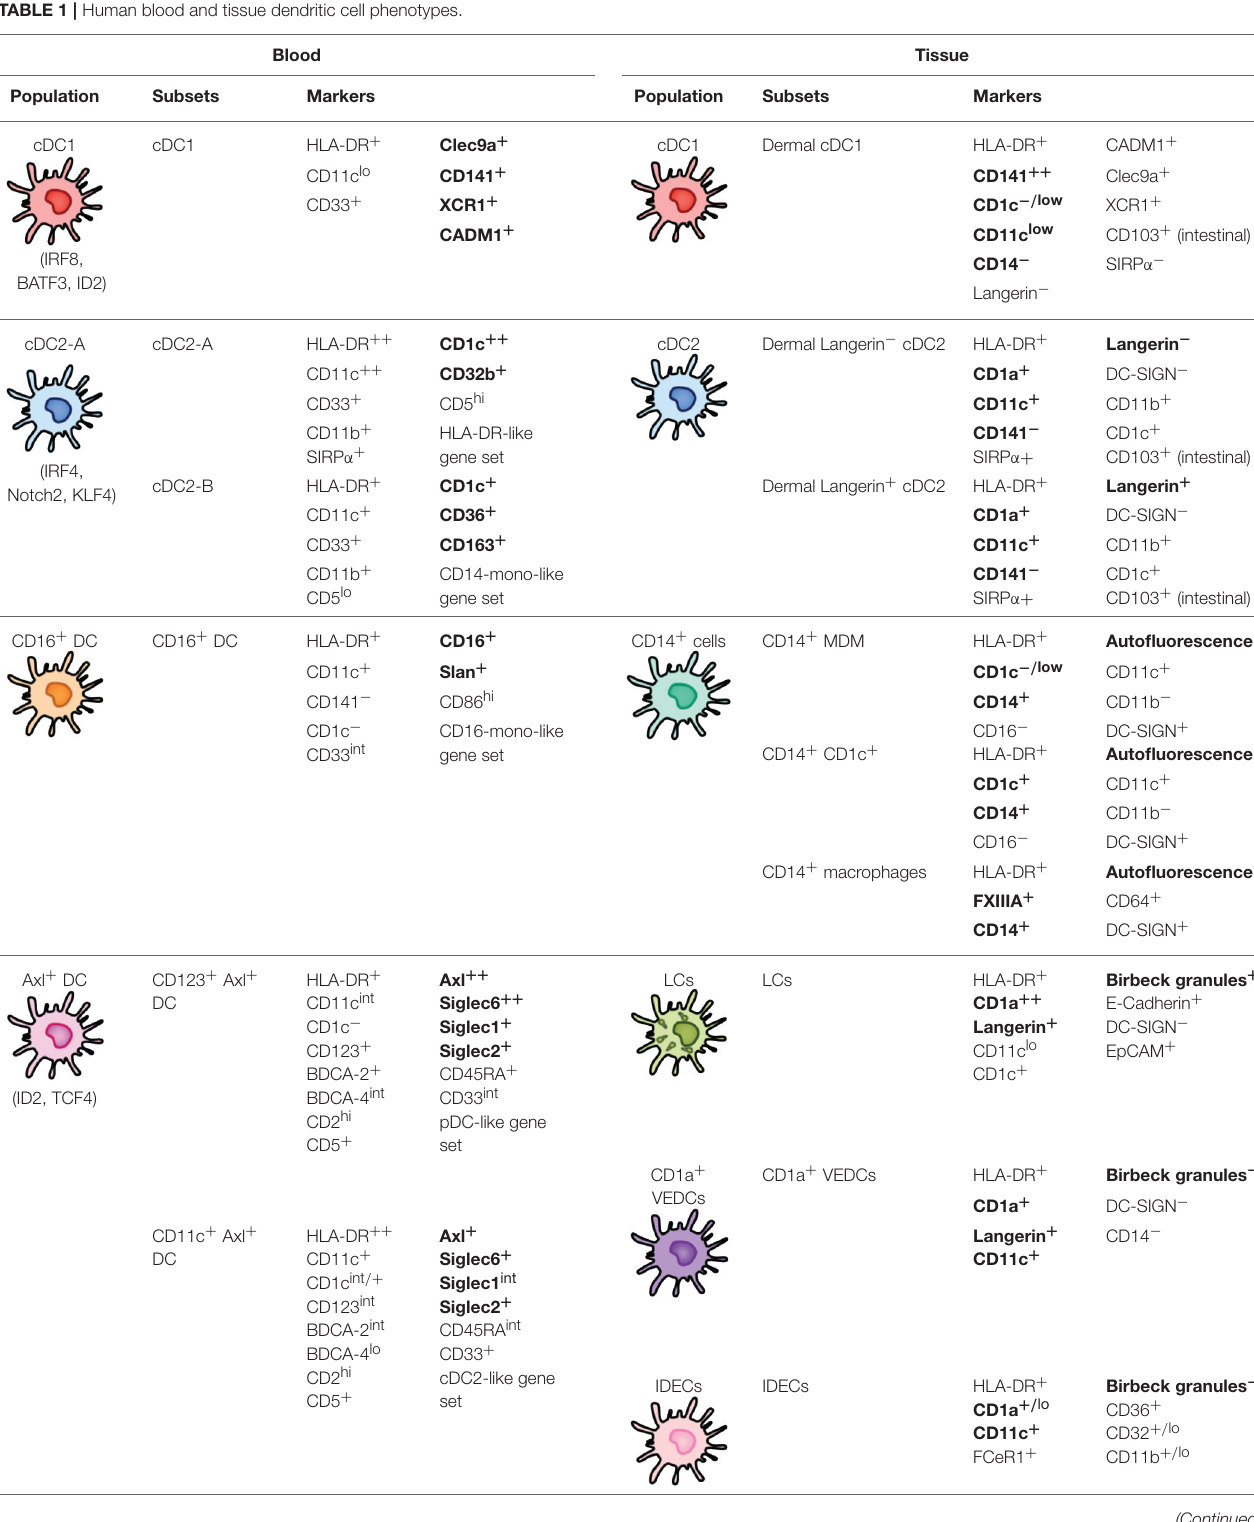
TABLE 1 | Human blood and tissue dendritic cell